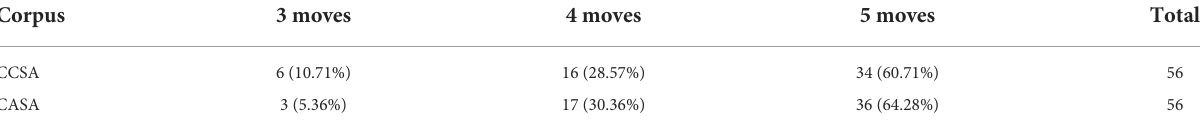
TABLE 3 General move structure of abstracts in CCSA and CASA.